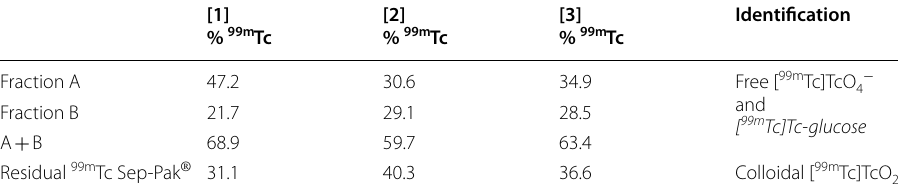
Table 6 Distribution of [ 99m Tc]Tc-glucose on Sep-Pak ® cartridge